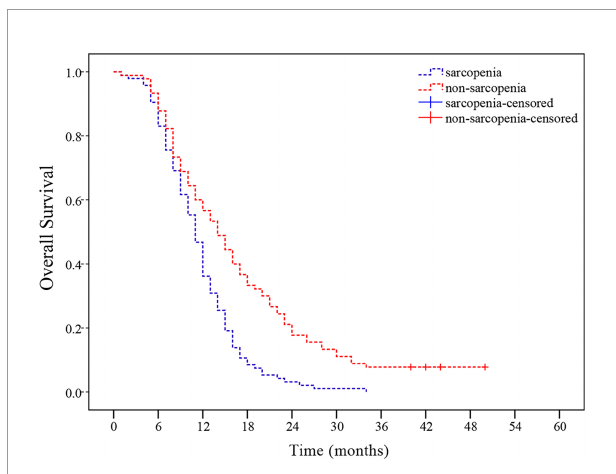
FIGURE 2 | Sarcopenia at presentation and overall survival (OS). Patients with sarcopenia had worse OS than those without sarcopenia ( p <